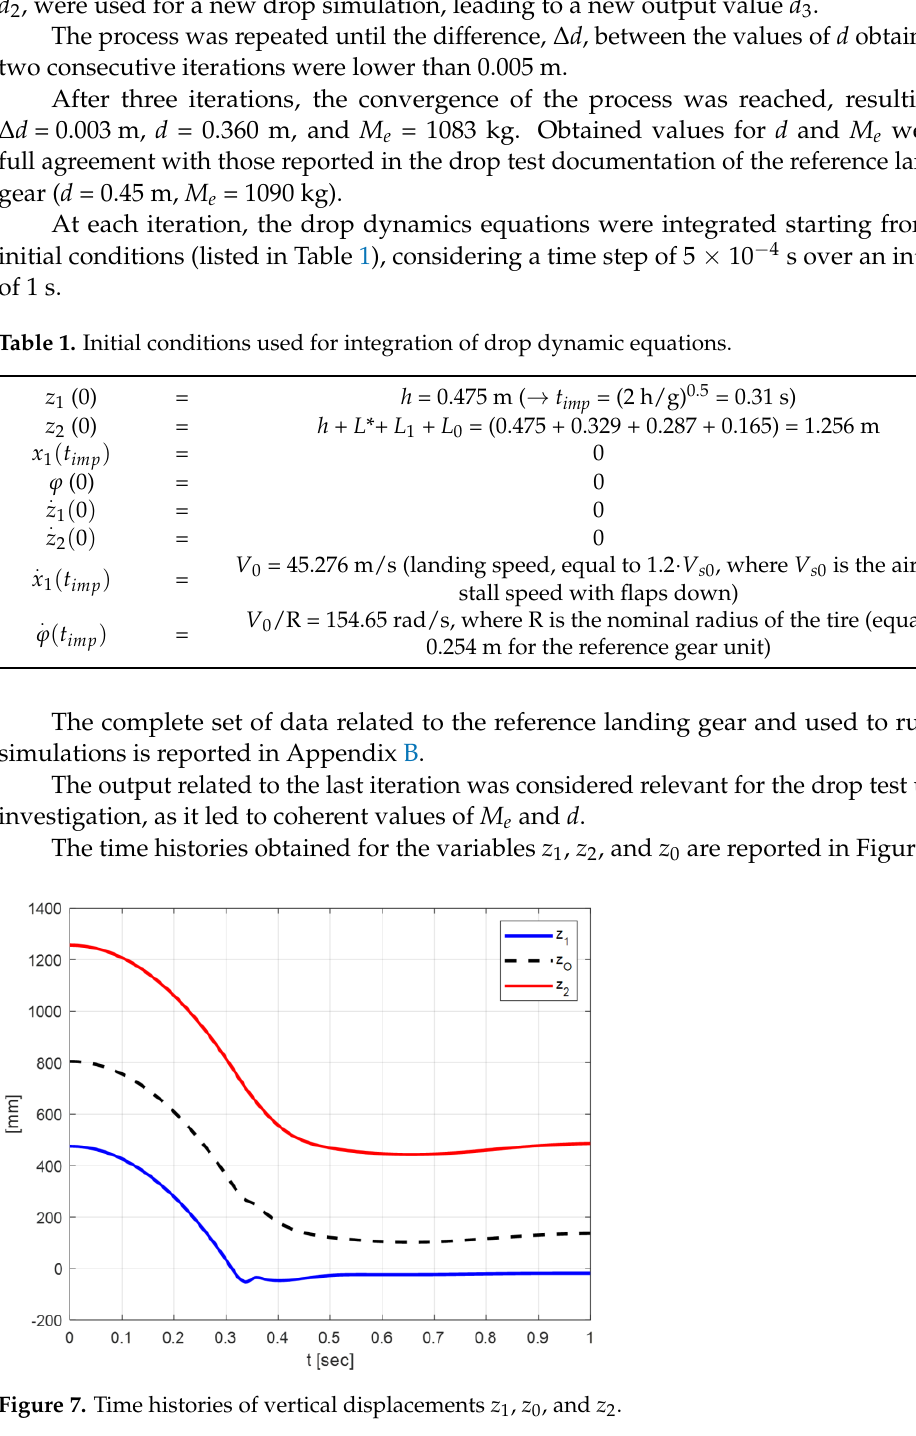
Figure 8. Time history of piston stroke. After the impact, the piston stroke increases up to its maximum value; in this time interval, z 1 , z 0 , and z 2 continue to decrease coherently to what is expected during the shock absorber’s compression. Their trends are now different and no longer parabolic, as they are influenced by the shock absorber dynamics and the crushing of the tire. The tire’s crushing effect is more evident in the wheel hub vertical displacement ( z 1 ) and becomes less dominant for z 0 and z 2 due to the shock absorber’s damping action. When the piston stroke decreases, the shock absorber starts its extension phase and the displacements z 1 , z 0 , and z 2 consequently increase. During this phase, the vertical displacement trends are practically affected only by the shock absorber’s dissipation force. This is even more evident if we consider the time histories of the effective mass ac- celeration ( 𝑧̈ 2 (𝑡) ) (Figure 9) and the overall shock absorber force F sa ( t ) = ( F a ( t ) + F d ( t )) (Fig- ure 10).